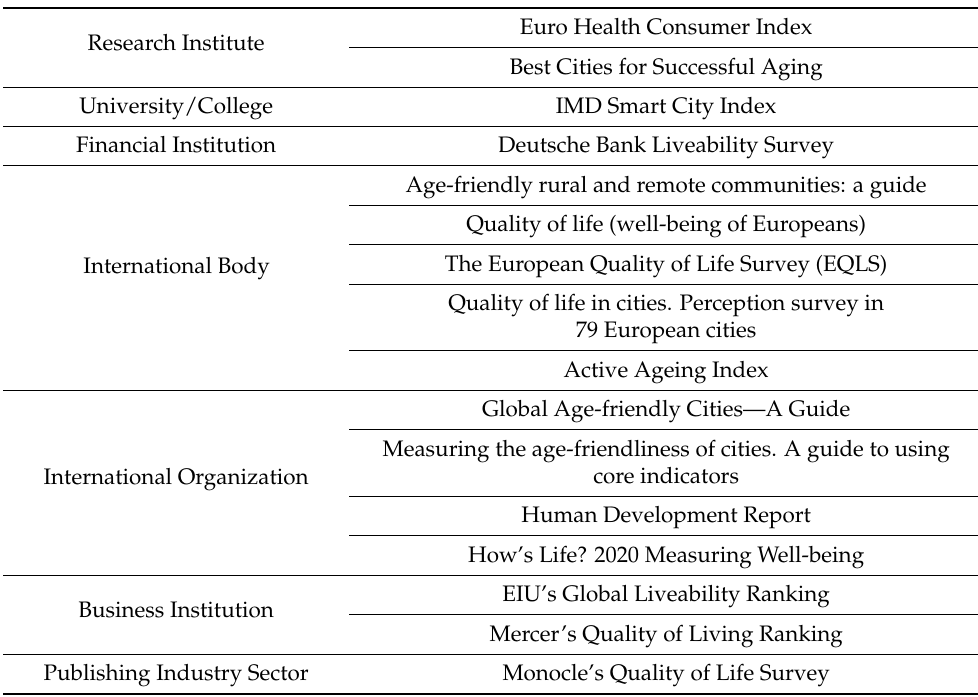
Table 6. Classification of tools. Type of contracting